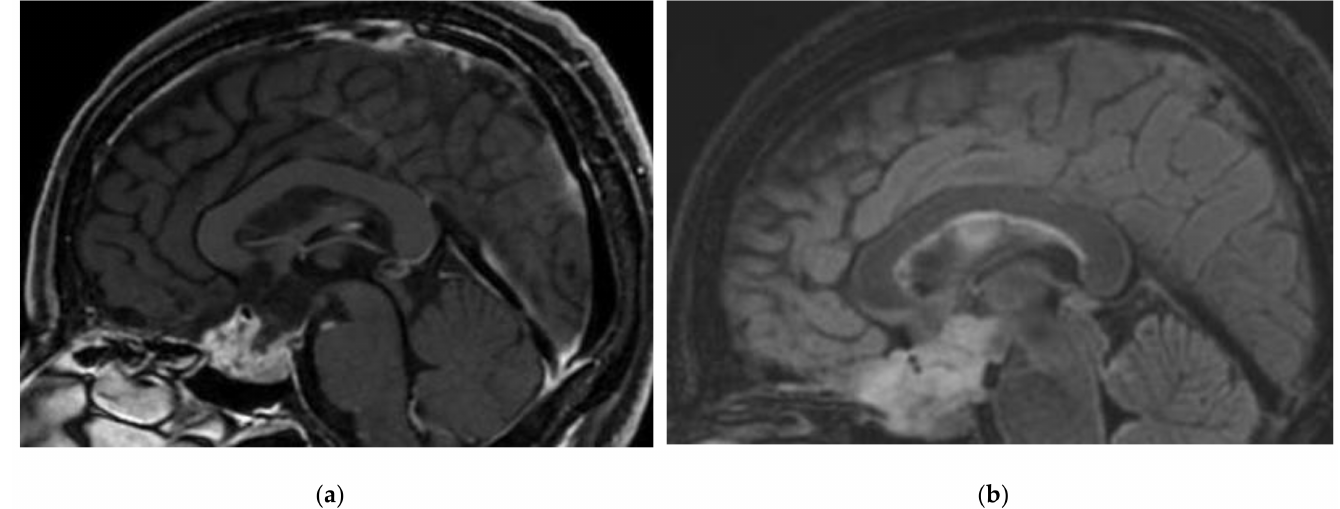
Figure 2. A 40-year-old female with Rosette-forming glioneuronal tumour (RGNT) of hypotha- lamic region, an incidental finding on an MRI performed for vertigo investigations. No disease activity after subtotal resection. Sagittal views: ( a ) T1-weighted images after gadolinium infusion; ( b ) Flair-weighted sequence.